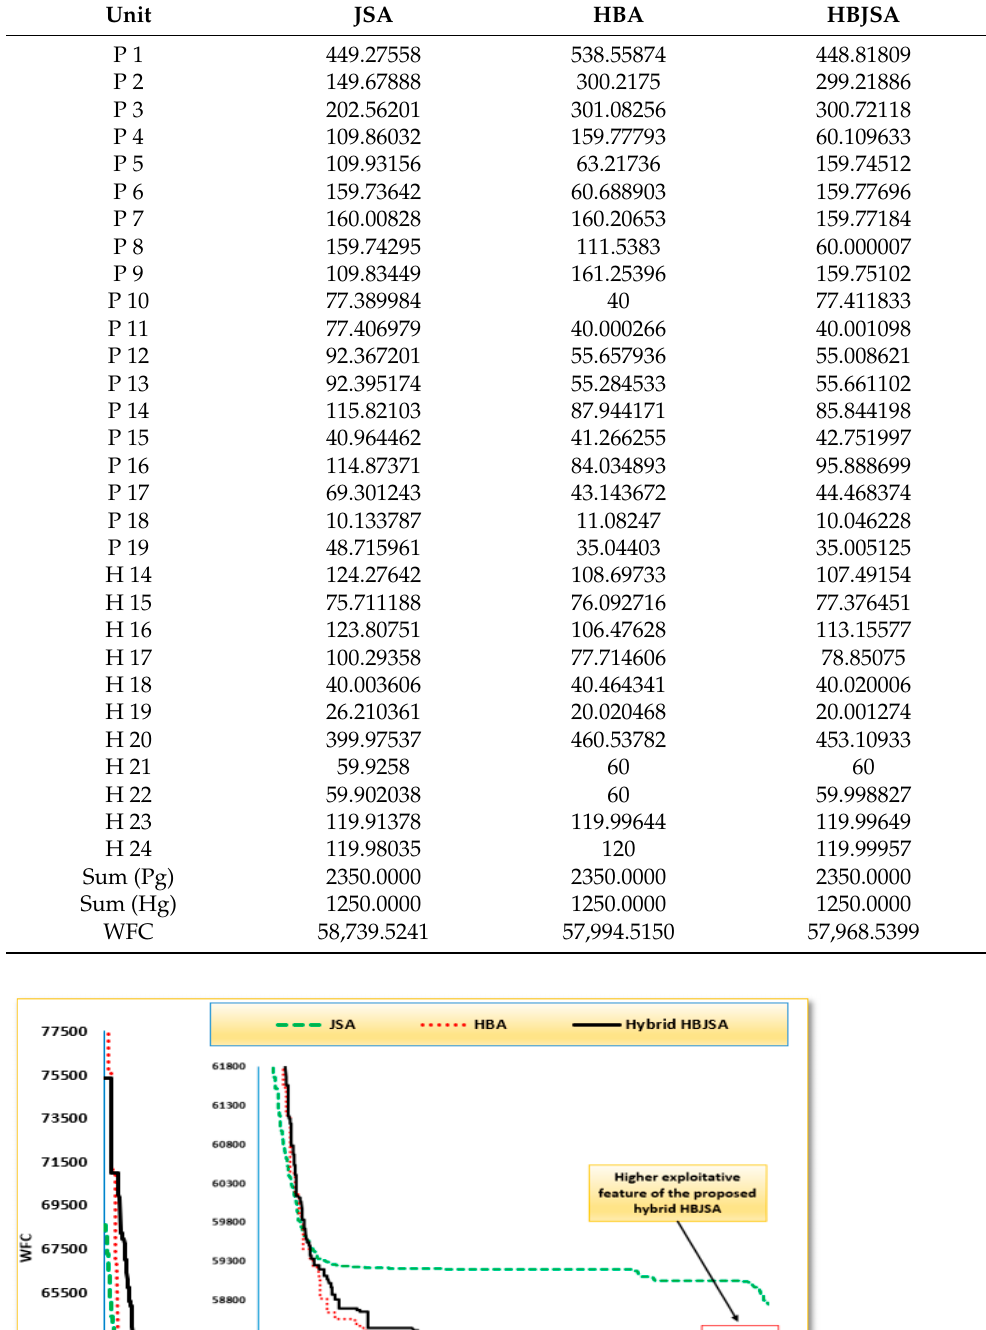
Table 1. Comparison between HBA, JSA, and the proposed HBJSA for the 24-unit test system of CHP economic dispatch problem.